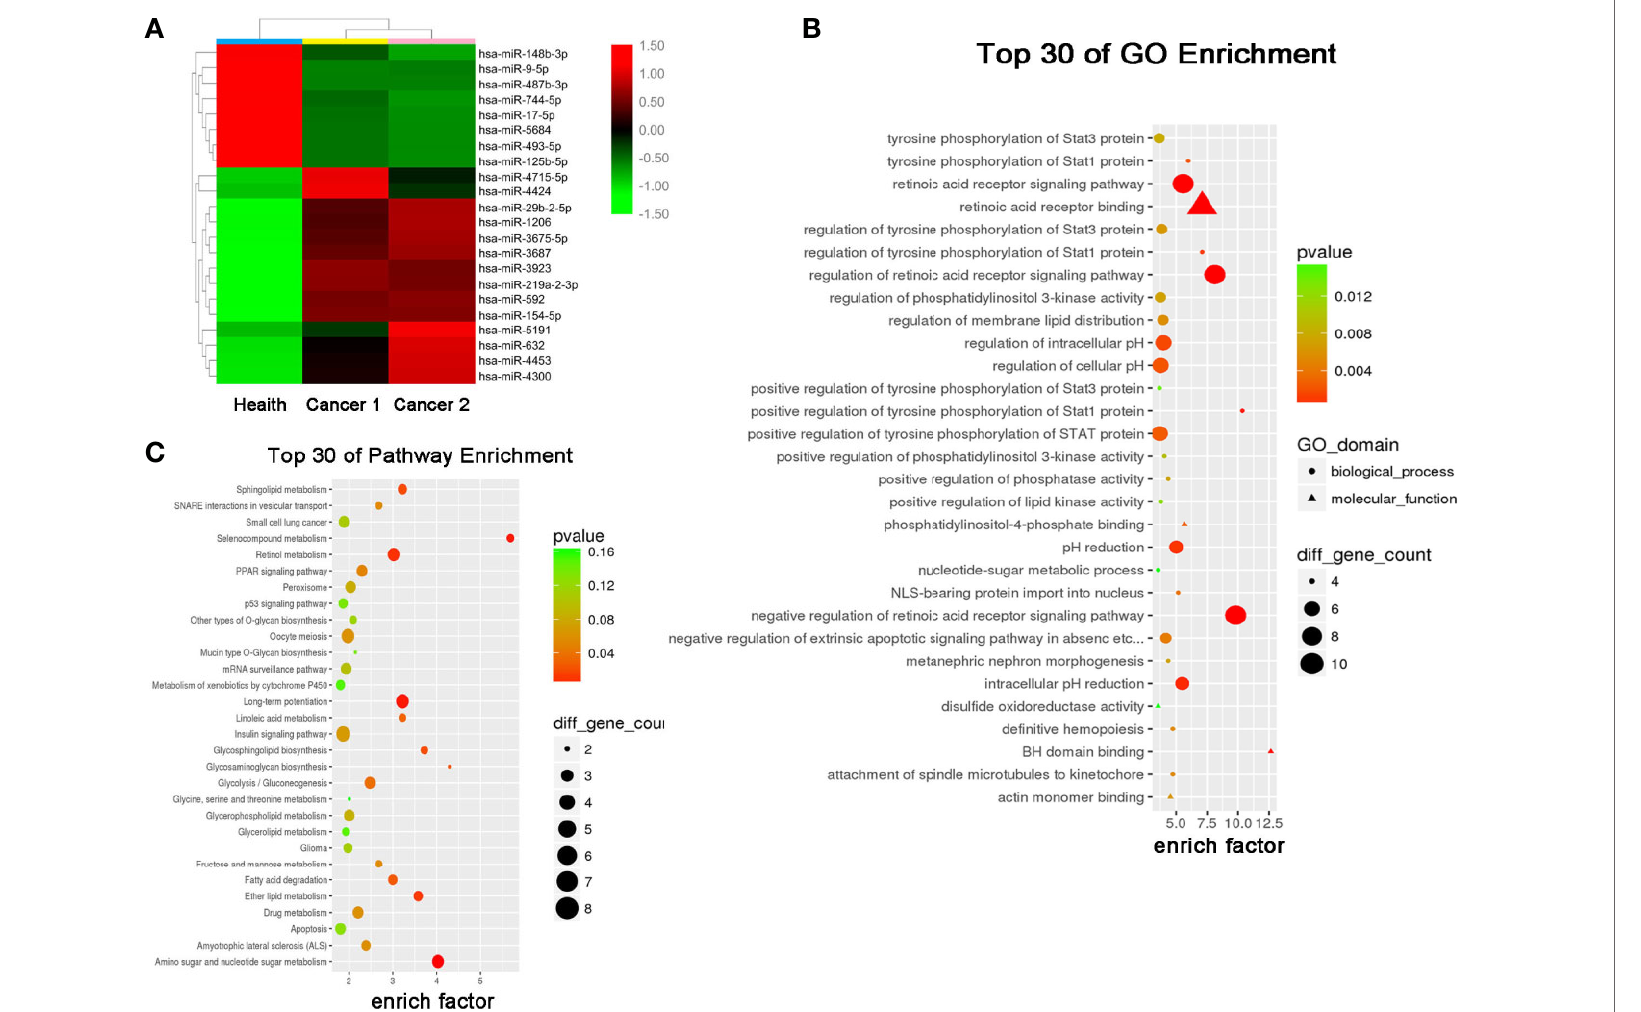
FIGURE 2 | Serum exosomal miRNA pro fi le of the NSCLC patients. (A) Cluster analysis of differentially expressed serum exosomal miRNAs between 1 healthy donor and 2 NSCLC patients. Candidate target genes were predicted by (B) KEGG enrichment analysis and (C) GO